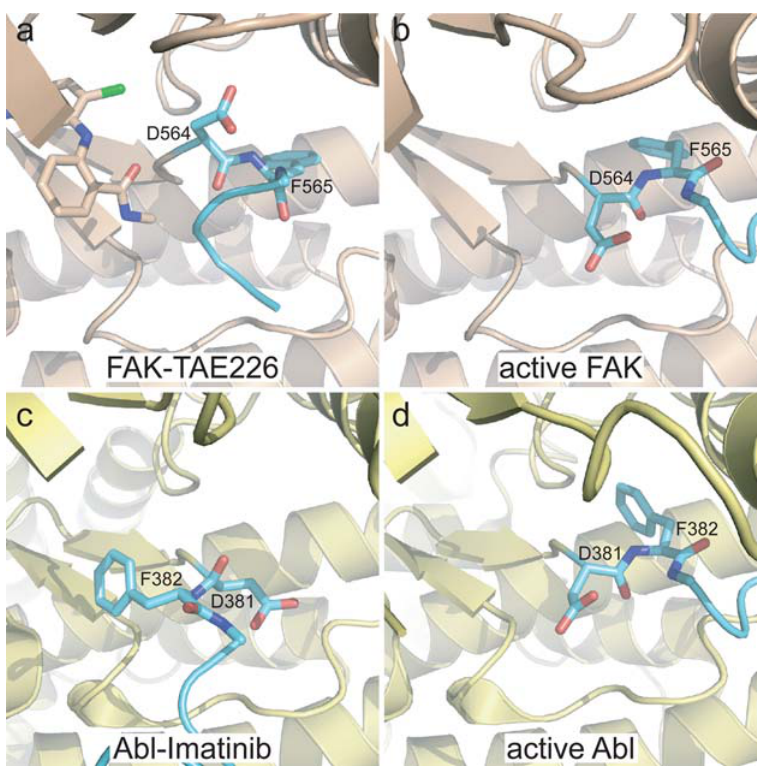
Figure 4. Partial DFG flip in TAE226 bound FAK. (a–b). The phi backbone torsion angle of D564 in TAE226 bound FAK (a) is rotated by approximately 110 u compared to FAK in the active conformation (b) (pdb accession 2j0l). This results in the side chain of D564 pointing upwards towards the N-lobe. FAK is colored beige with its activation loop in cyan. TAE226 (a) and the DFG motif are shown in stick representation. For clarity, residues 429–434 in the P-loop and AMP-PNP in active FAK are removed. (c–d) In Abl, D381 of the DFG motif is flipped by approximately 180 u in the imatinib bound form (c) (pdb accession 1opj) compared to the active conformation (d) (pdb accession 2g2i). Abl is colored pale yellow with its activation loop in cyan. The ligands imatinib (c) and ADP (d) as well as residues 251–255 in the P-loop are removed because they obstruct the view of the DFG motif.